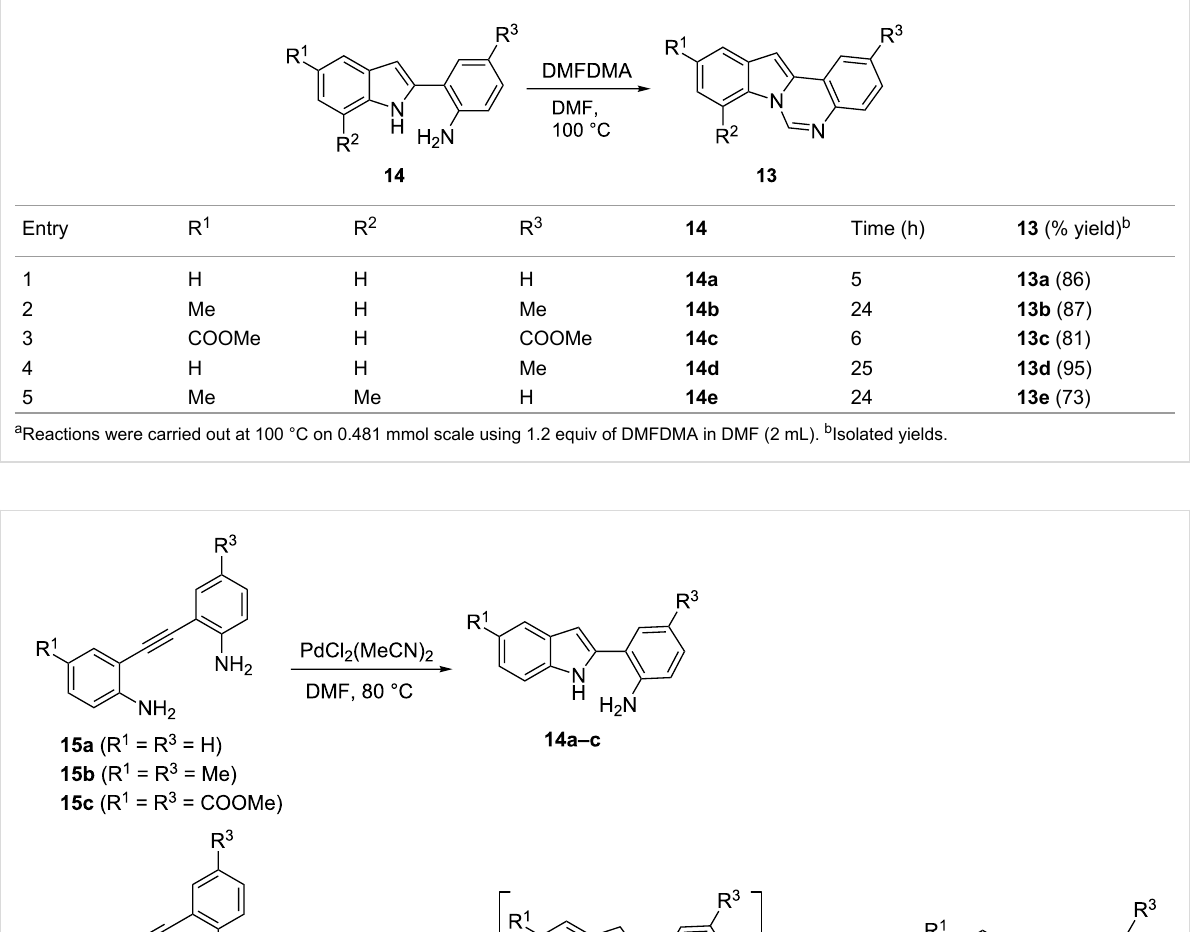
Table 2: Synthesis of 12-unsubstituted indolo[1,2- c ]-quinazolines 13 .